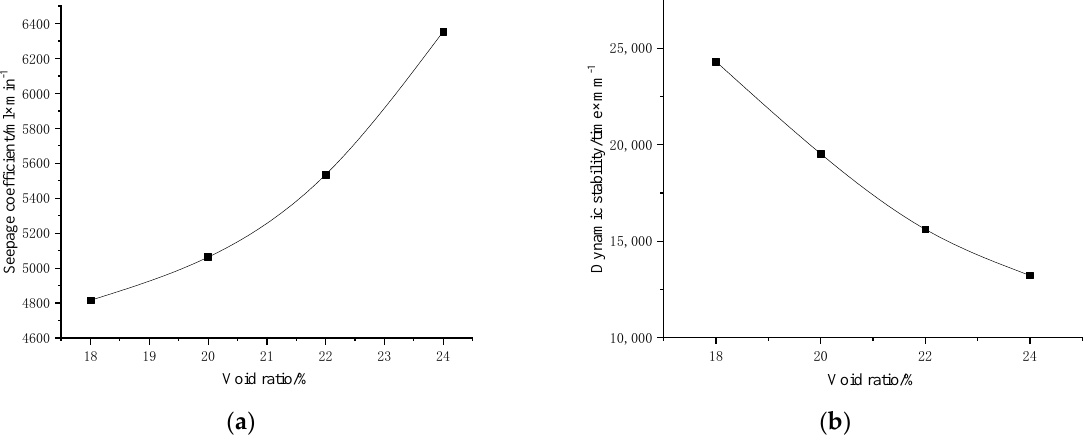
Figure 12. Relationship between void ratio and performance of drained epoxy asphalt mixture: ( a ) Diagram of void ratio versus permeability coefficient; ( b ) Diagram of void ratio and dynamic